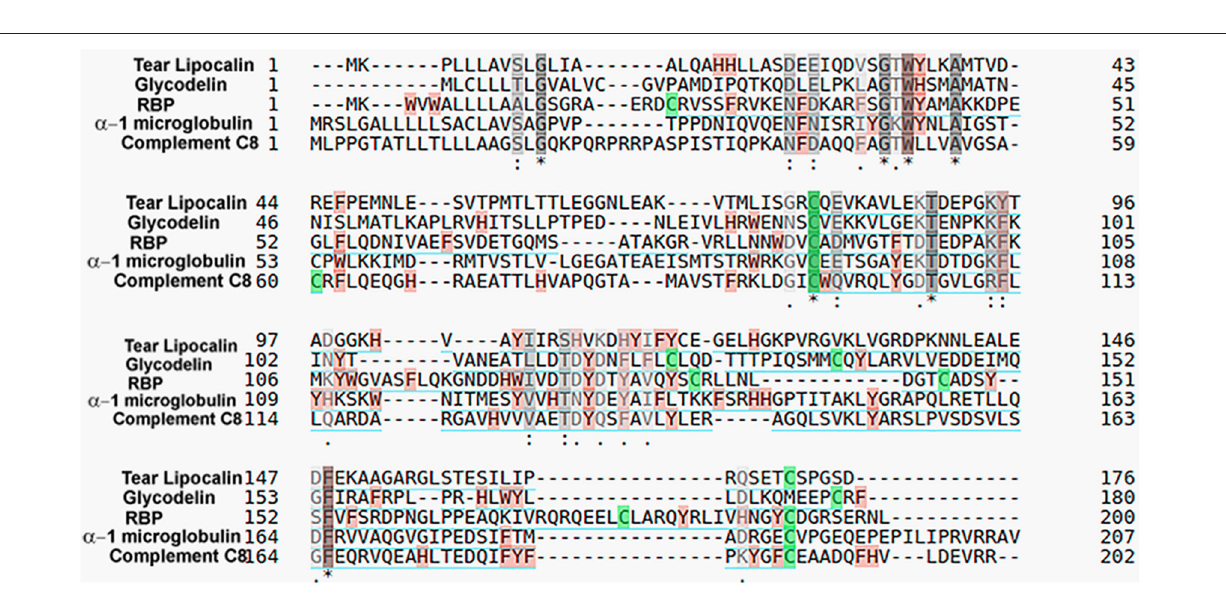
FIGURE 2 | Comparison of representative human lipocalins for amino acid sequence identity. Colors indicate disulfide bonds (green), aromatic residues (tan), and similar amino acid properties (gray). Asterisk (*) indicates a fully conserved sequence, colon (:) indicates groups of strongly similar properties and period (.) indicates groups of weakly similar properties. Sequence identity was determined by the Universal Protein Resource (https://www.uniprot.org/align/) with protein accession numbers: P31025-tear lipocalin, P09466-glycodelin, P02753-retinol-binding protein 4 (RBP), and P07360-complement component C8 gamma